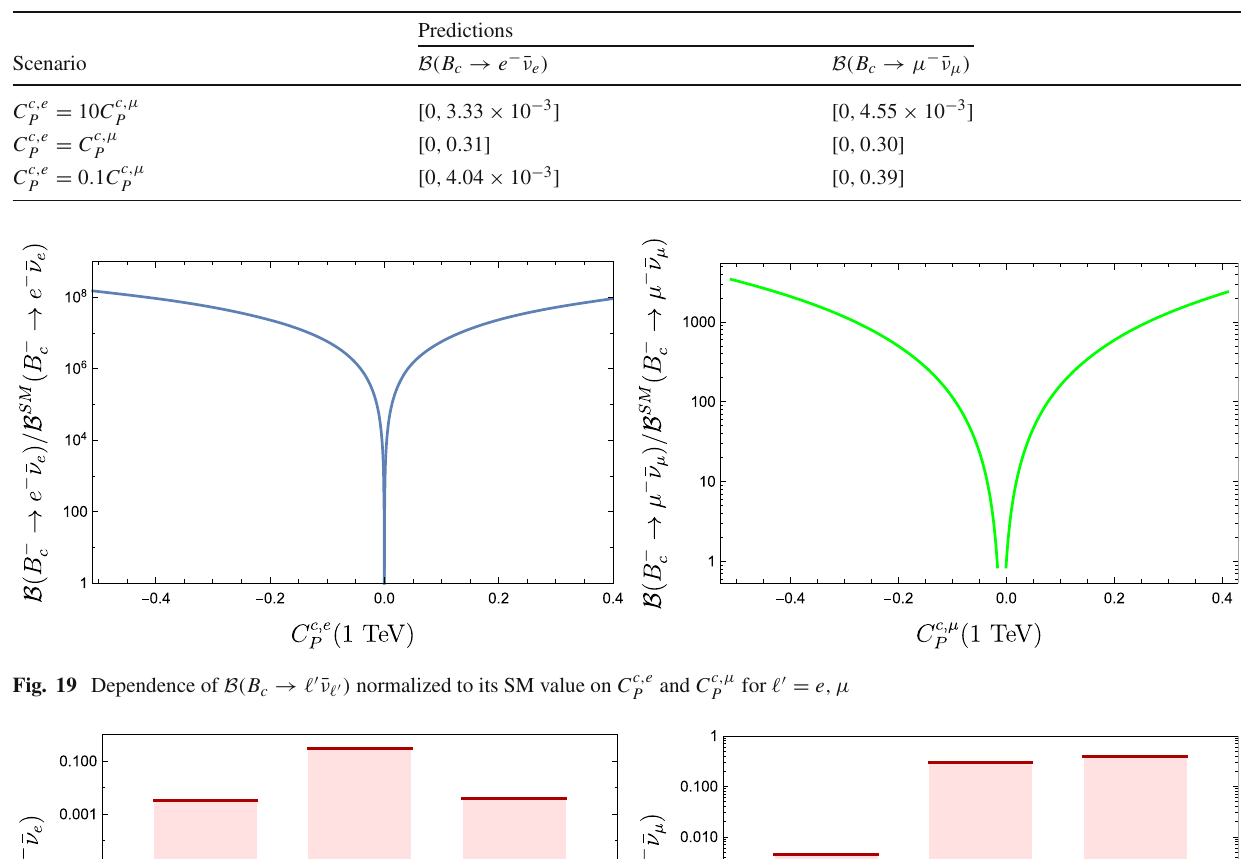
Table 11 Predictions of B ( B c → (cid:2) (cid:6) − ¯ ν (cid:2) (cid:6) ) in the presence of a NP Wil-